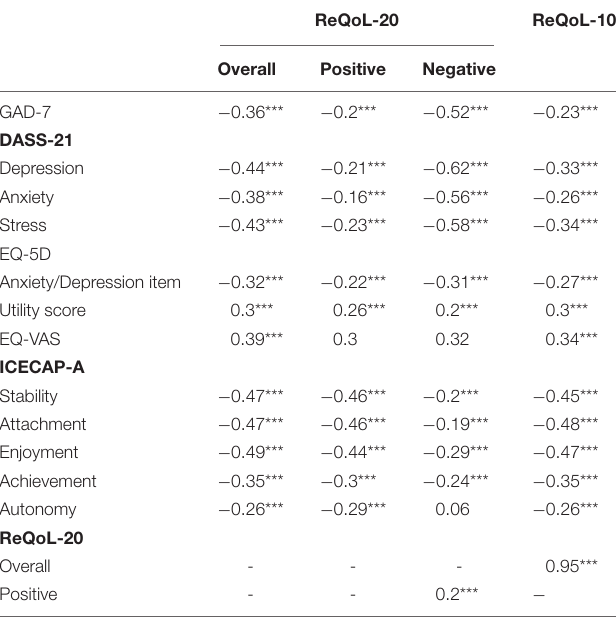
TABLE 5 | Convergent validity of the ReQoL-TC.